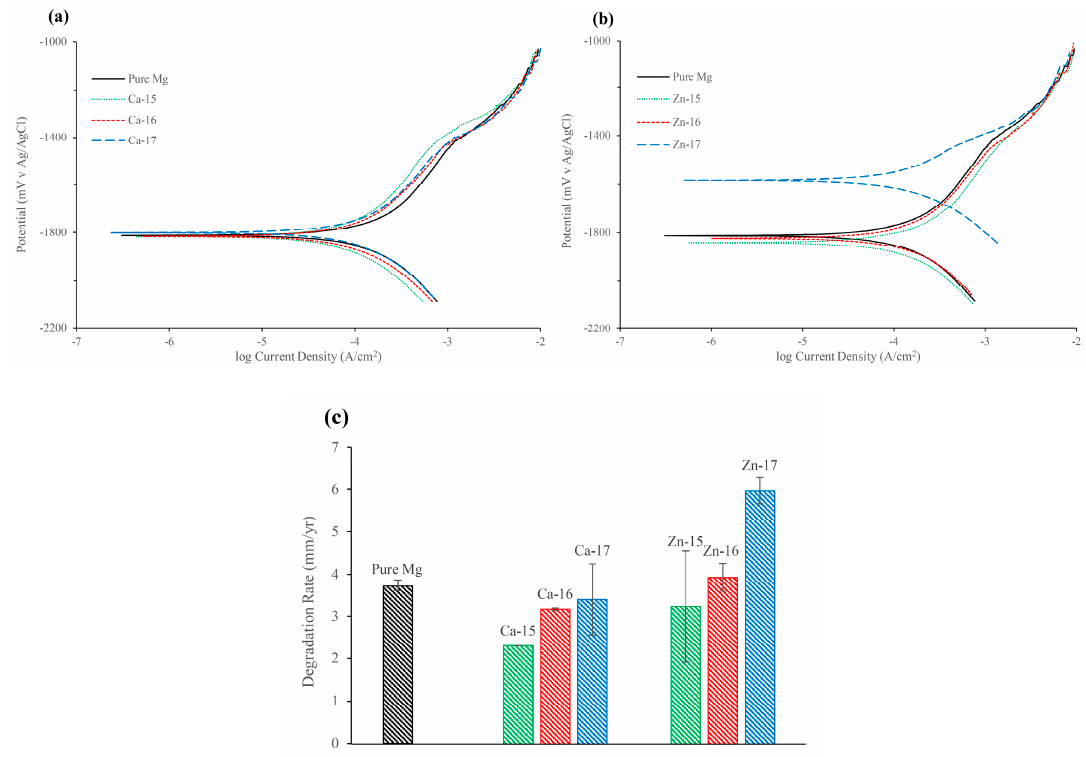
Figure 3. Potentiodynamic polarisation plots of: ( a ) Ca-ion; and ( b ) Zn-ion implanted magnesium in SBF; and ( c ) degradation rate of Ca-ion and Zn-ion implanted magnesium in SBF.